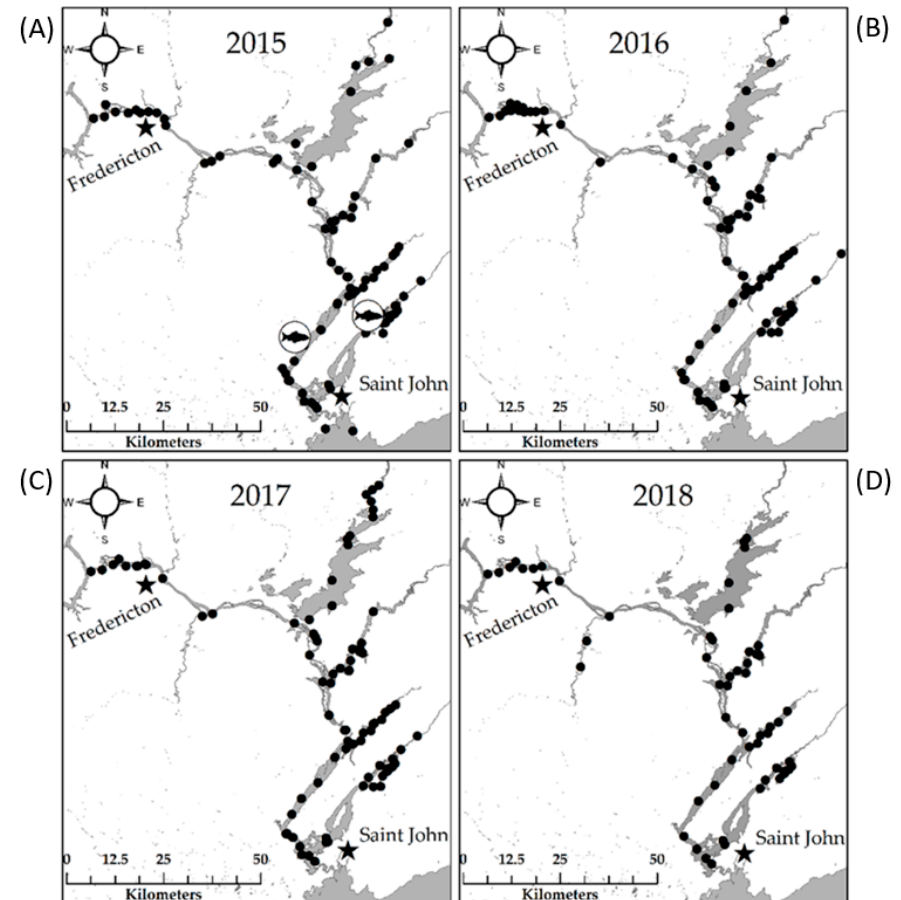
Figure 4. Underwater camera ( A ) setup. Two scuba diving flashlights ( B ) are used to facilitate filming close to the bottom. A downrigger ( C ) with a 10 lb weight ( D ) was used to lower the camera down and the fins ( E ) are designed to keep the camera facing parallel to the bottom.